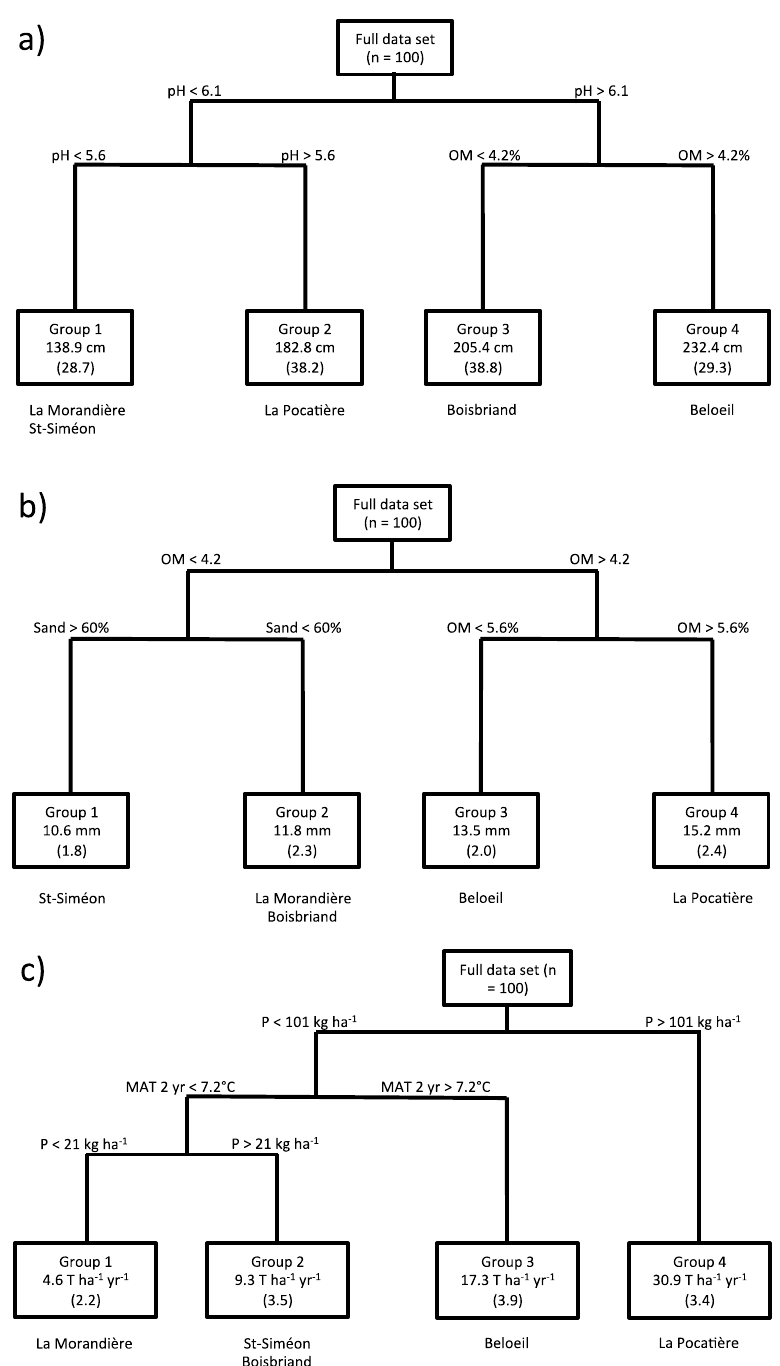
Figure 5. Regression tree model for stem height ( a ), stem diameter ( b ), and biomass yield ( c ) in the two-year rotation willow SRC. MAT, mean annual temperature; OM, soil organic matter; P, soil extractible phosphorus; pH, soil pH; Sand, soil sand content. Splitting values are indicated along the branches, and boxes indicate terminal node mean (±standard error).